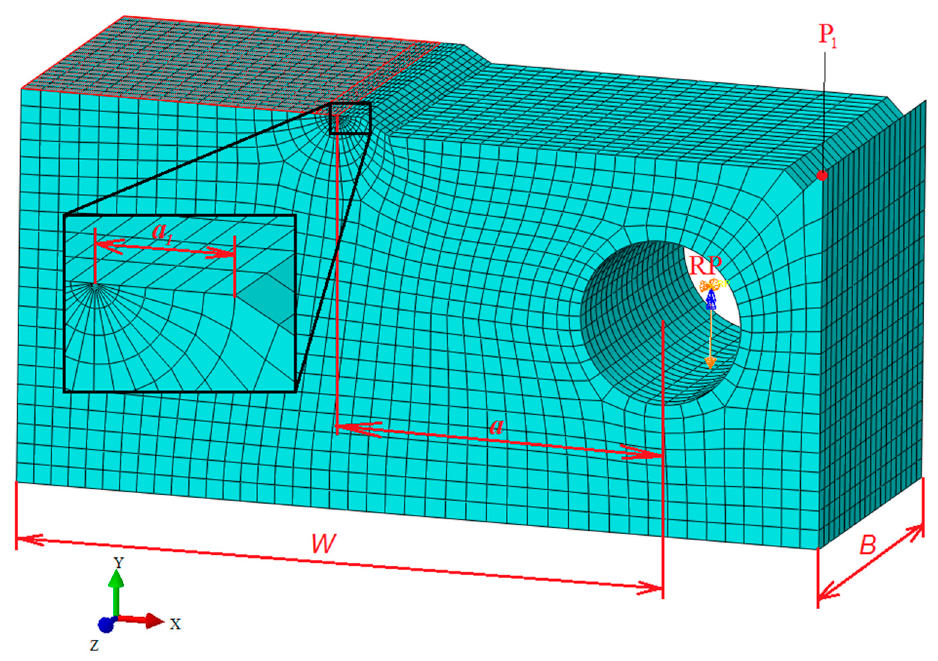
Figure 4. Finite element mesh of the C(T) specimen.